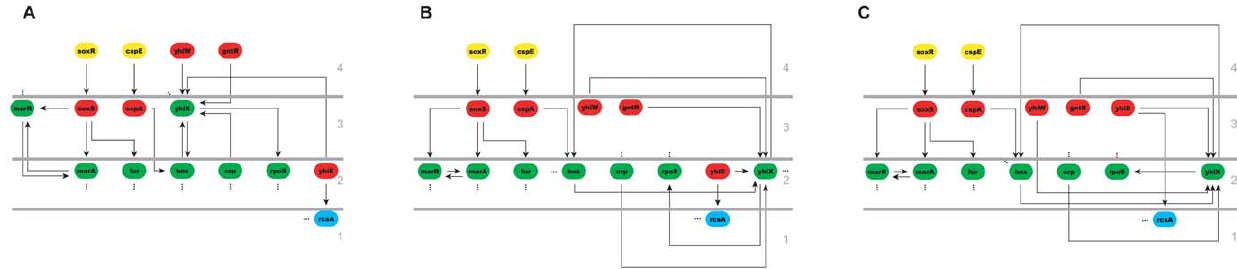
Figure 6. Comparison BFS-method vs. HiNO using the TRN of E. coli. A snapshot of the results (the comparison of the BFS-method and HiNO) using the TRN of E. coli is shown. Node colors indicate the level assignment in HiNO: blue - level 1; green - level 2; red - level 3; yellow - level 4. Dashed edges represent additional regulatory interdependencies (further up- and/or down-stream factors) that are not shown. The results of the BFS method are shown in ( A ). The node coloring indicates conflicts in level assignments. In ( B ) the result of the ‘‘downgrade’’ step of HiNO is shown. In ( C ) the result of the ‘‘upgrade’’ step is shown. This is also the final hierarchical assignment of the elements by HiNO. doi:10.1371/journal.pone.0013698.g006 PLoS ONE |